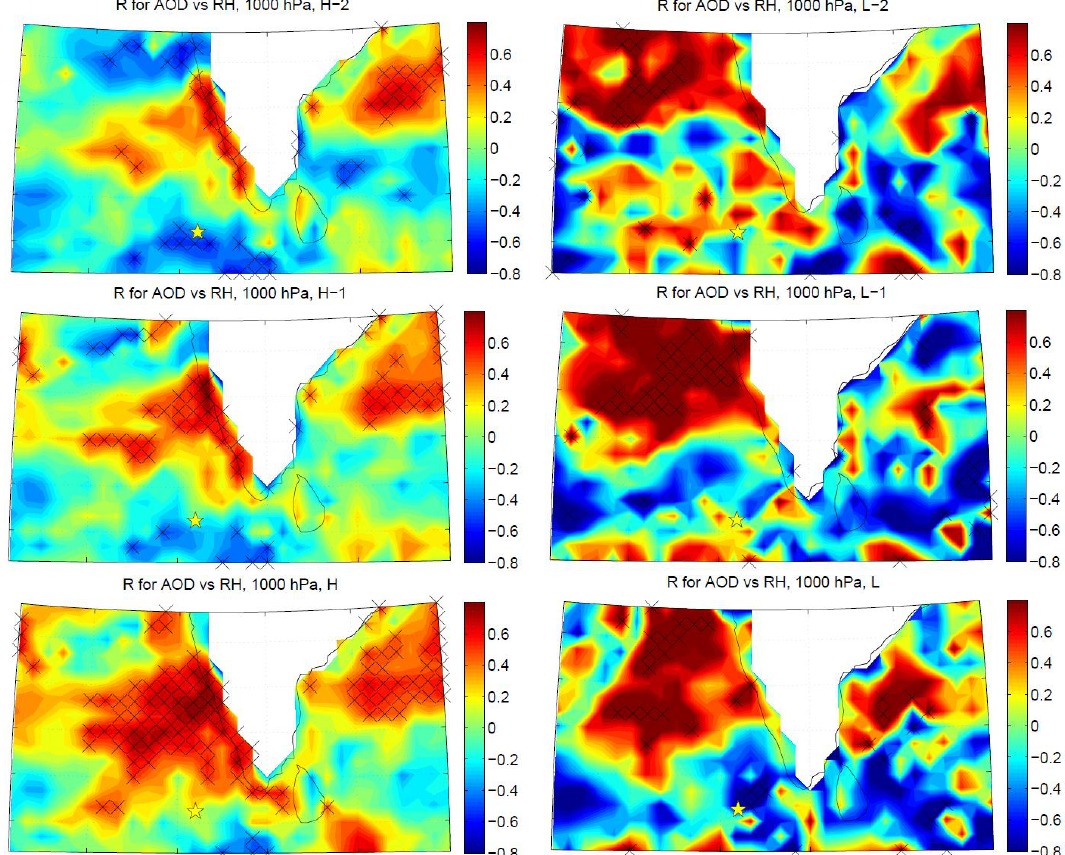
Figure 13. Correlation between MODIS AOD and ECMWF 1000hPa relative humidity for days leading up to high- (left) or low-pollution (right) events. The bottom row indicates the average of the days classified as a particular pollution event, while the middle and upper rows indicate the average of the previous 1 and 2 days, respectively. Hatching indicates a statistical significance at the 95%